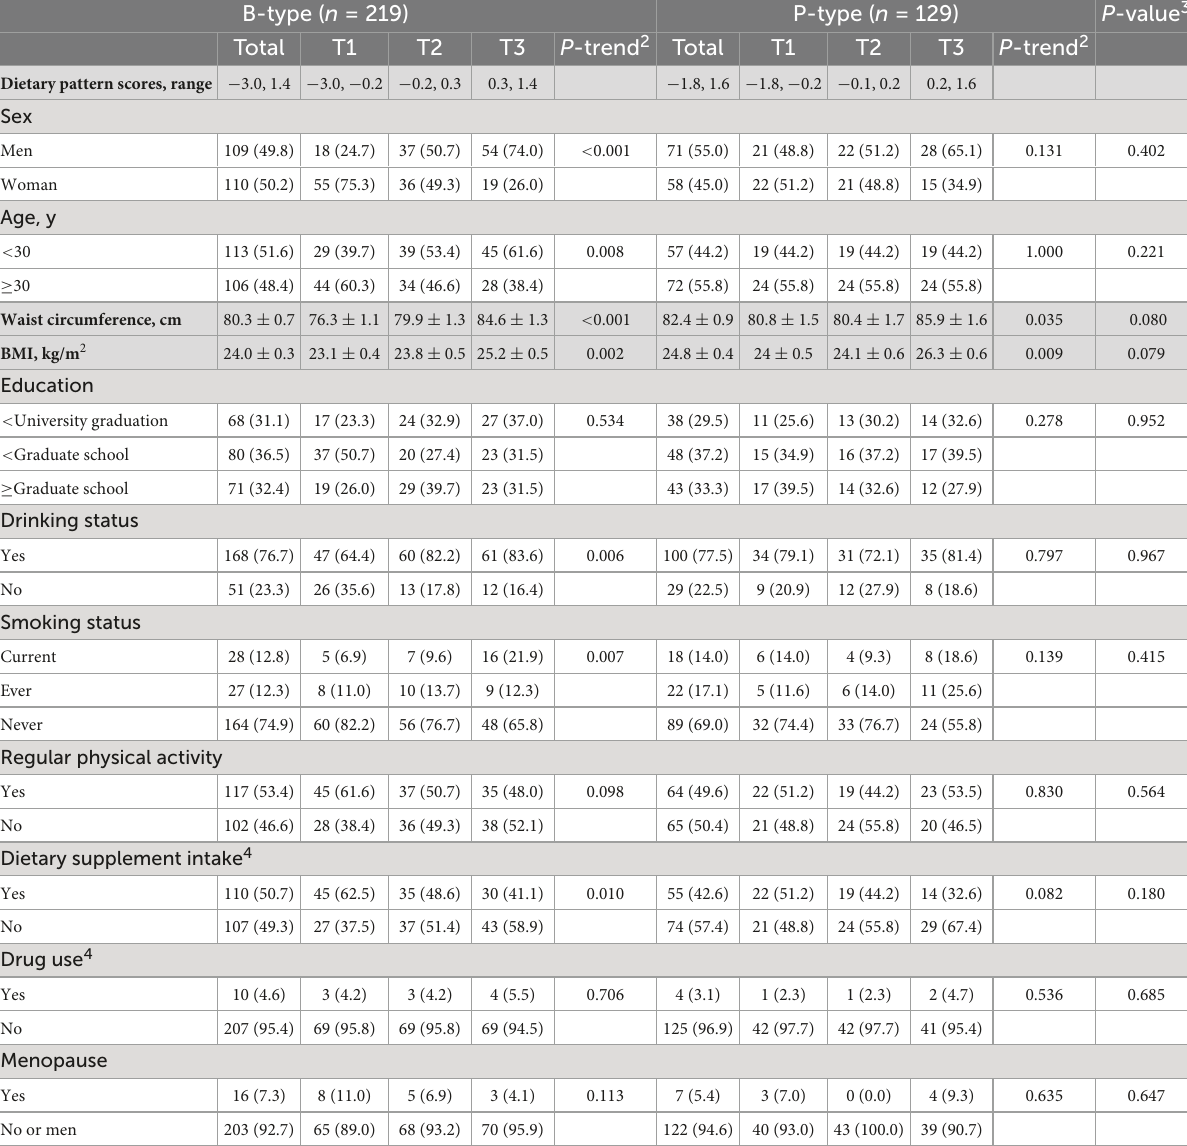
TABLE 2 Characteristics of the study participants across tertiles of dietary pattern scores by enterotypes 1